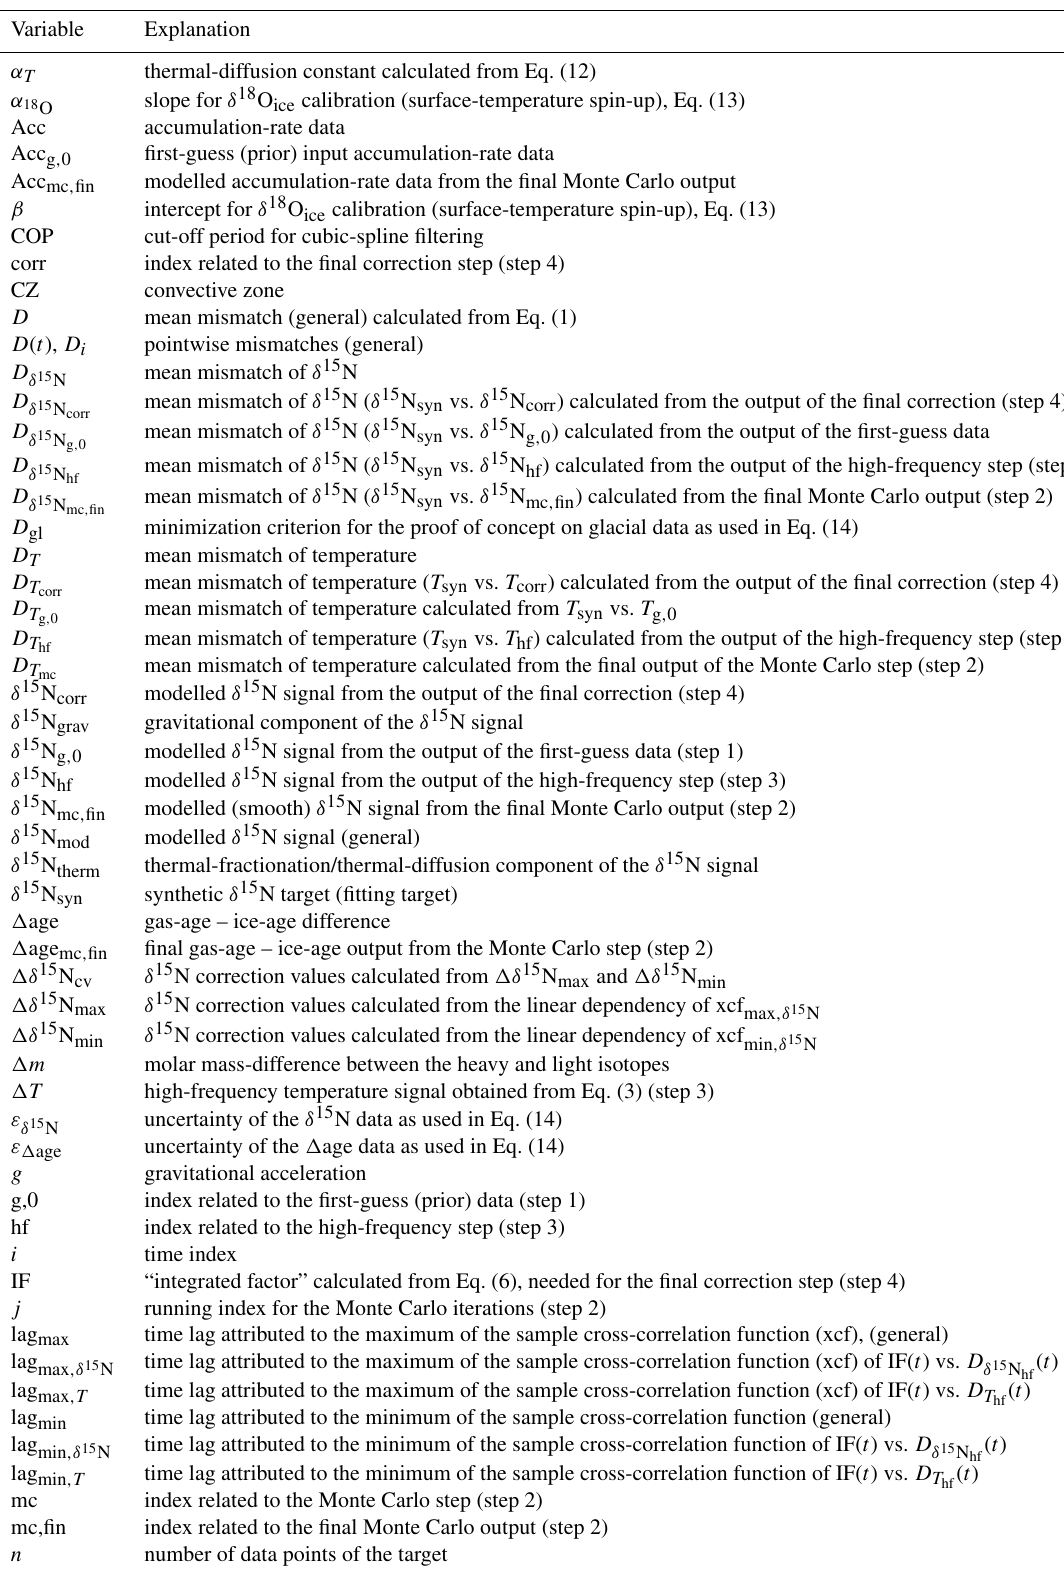
Table 1. Used variables and acronyms with their explanations. Variable